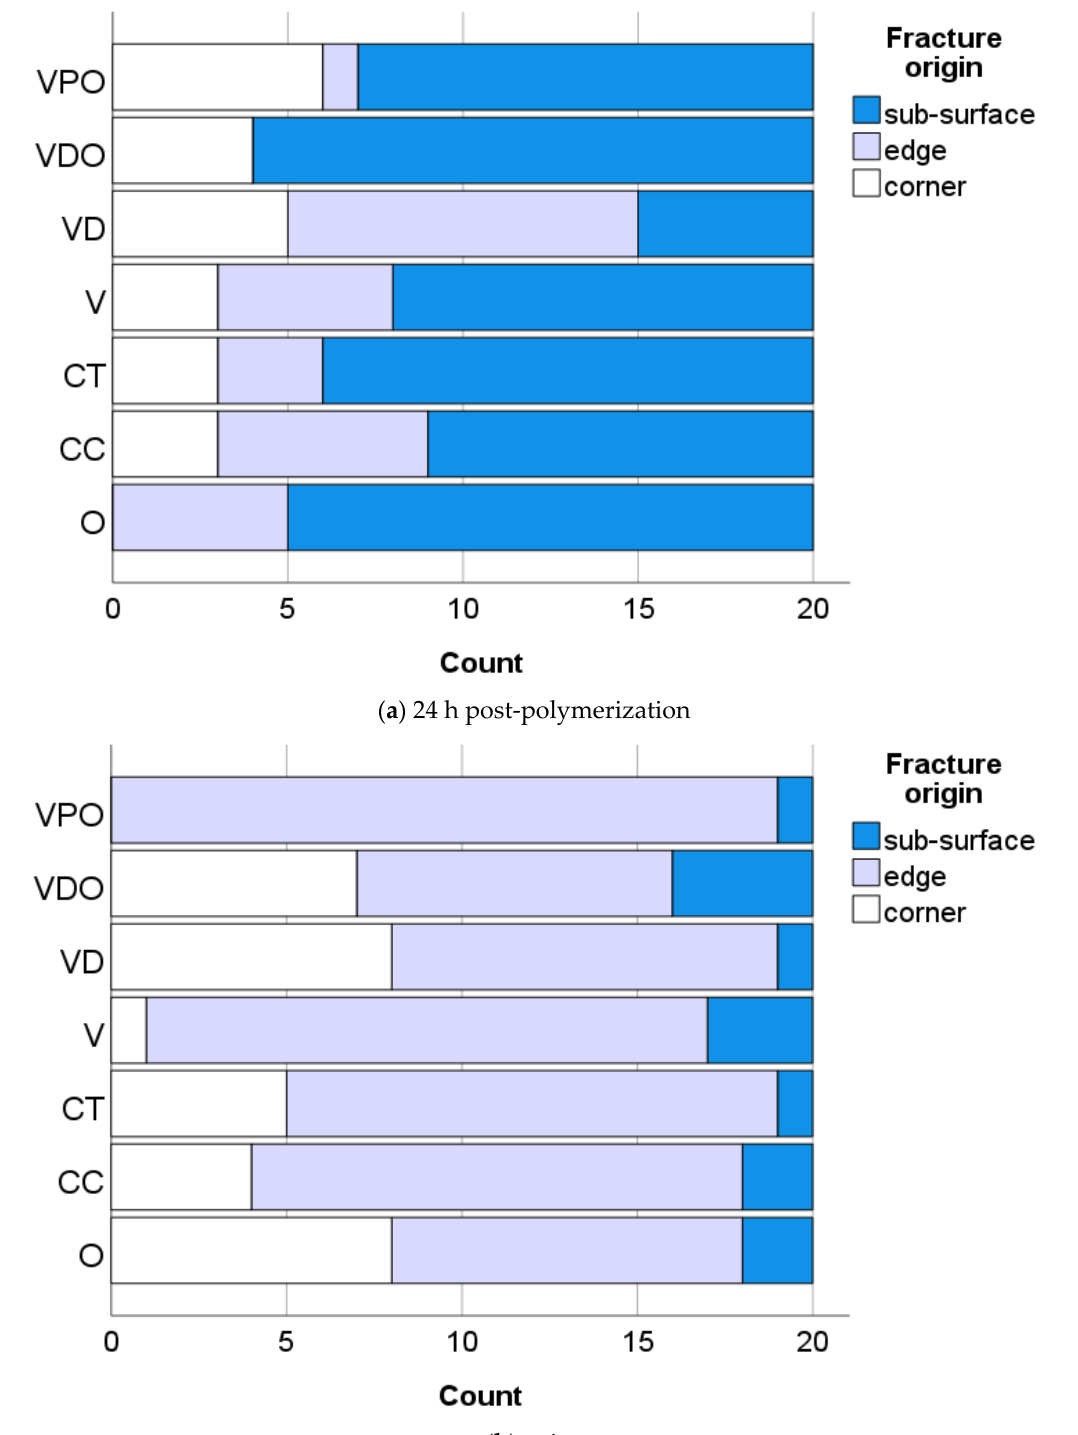
Figure 3. Fracture origin as a function of RBC and aging.